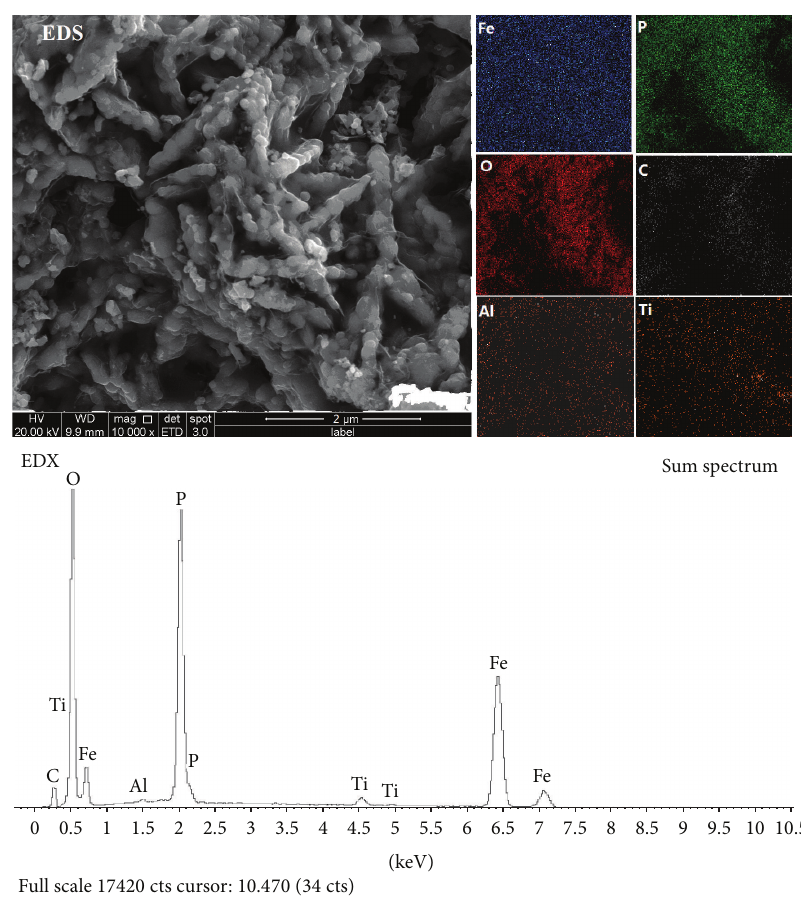
Figure 4: EDS and EDX images of spherical LiFePO 4 /C synthesized from spherical FePO 4 ⋅ 2H 2 O.